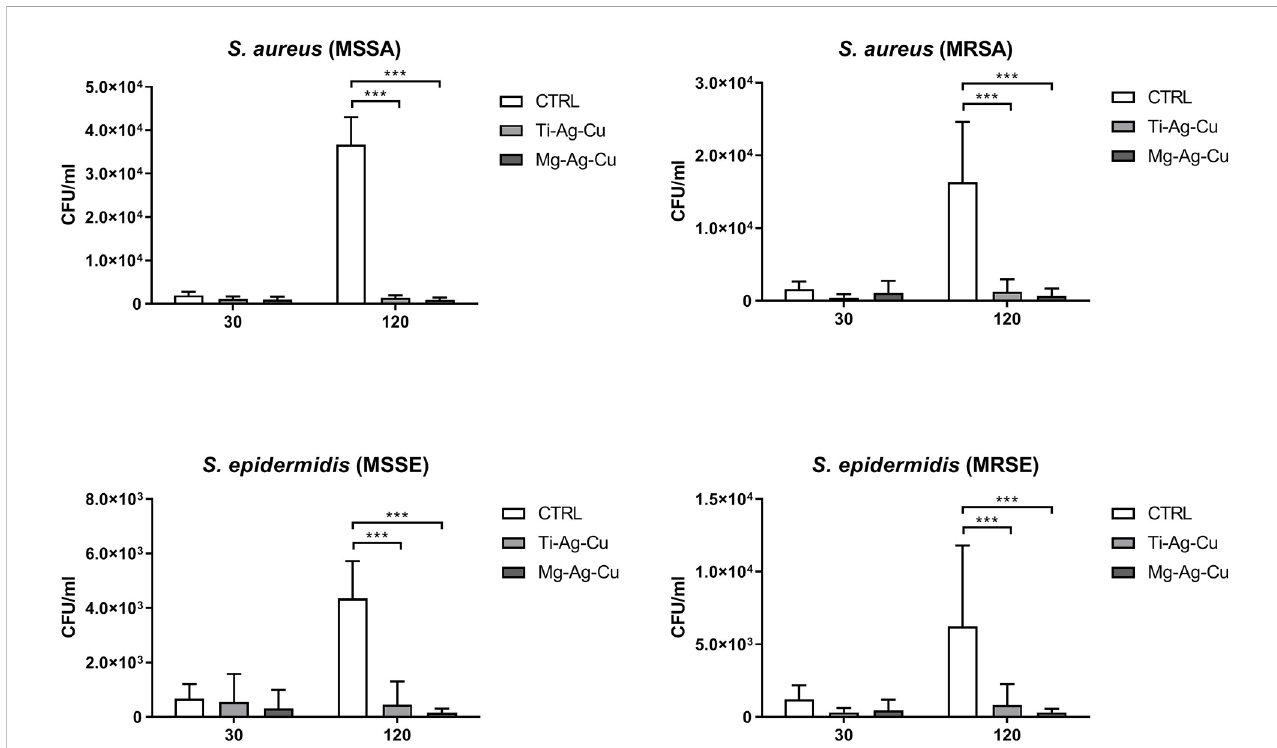
FIGURE 3 Staphylococcal adhesion on the surface of Ti-Ag-Cu and Mg-Ag-Cu-coated discs and uncoated glass surface (CTRL) after 30 and 120 minutes of incubation. Statistical signi fi cance: p < 0.001